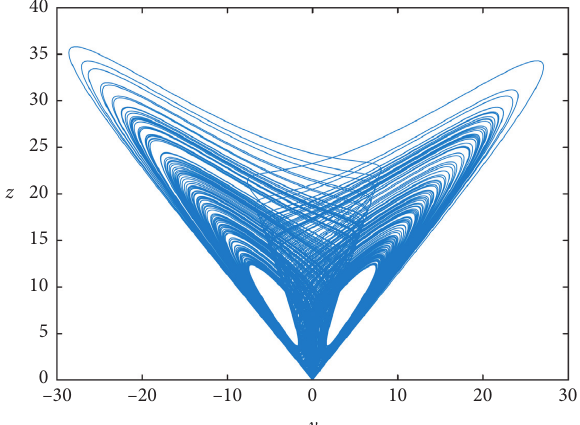
Figure 14: Dynamics of the fractional-order system in (13)–(15) with the order α � 0 . 92, in context of y and z directions.